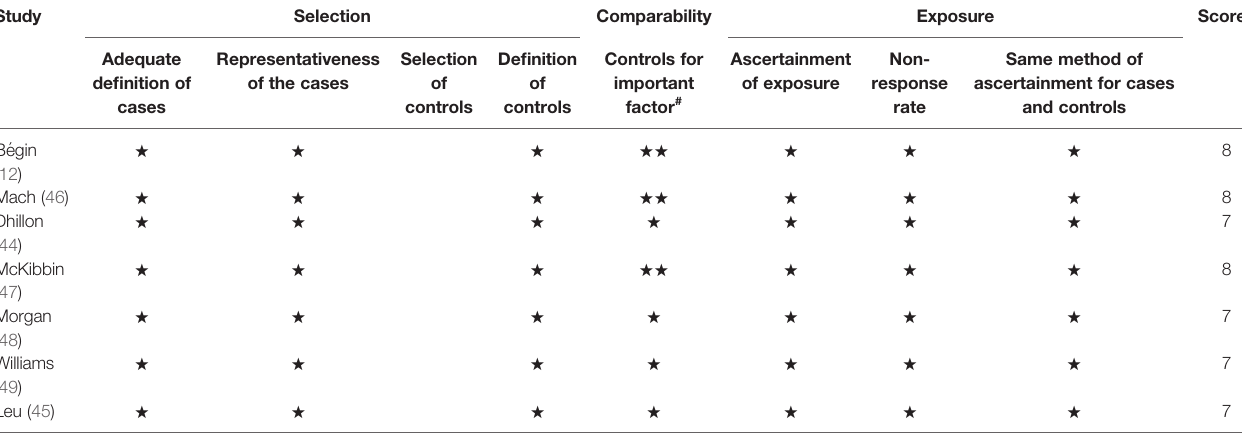
TABLE 3 | Results of quality assessment using the Newcastle-Ottawa Scale (NOS) for case – control